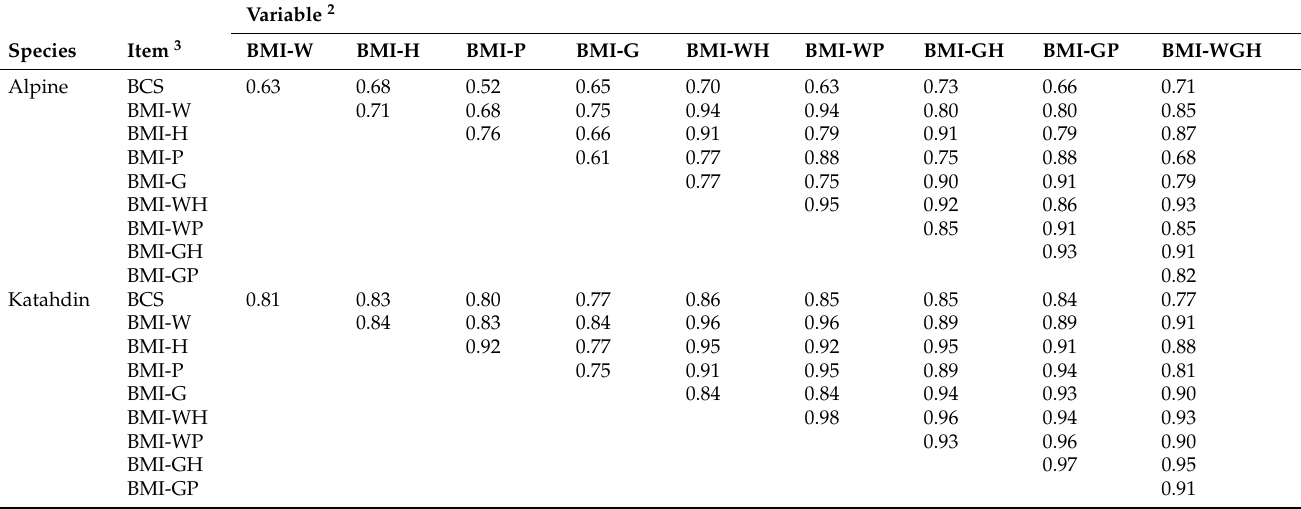
Table 3. Pearson correlation coefficients (r) between body condition score and body mass indexes 1